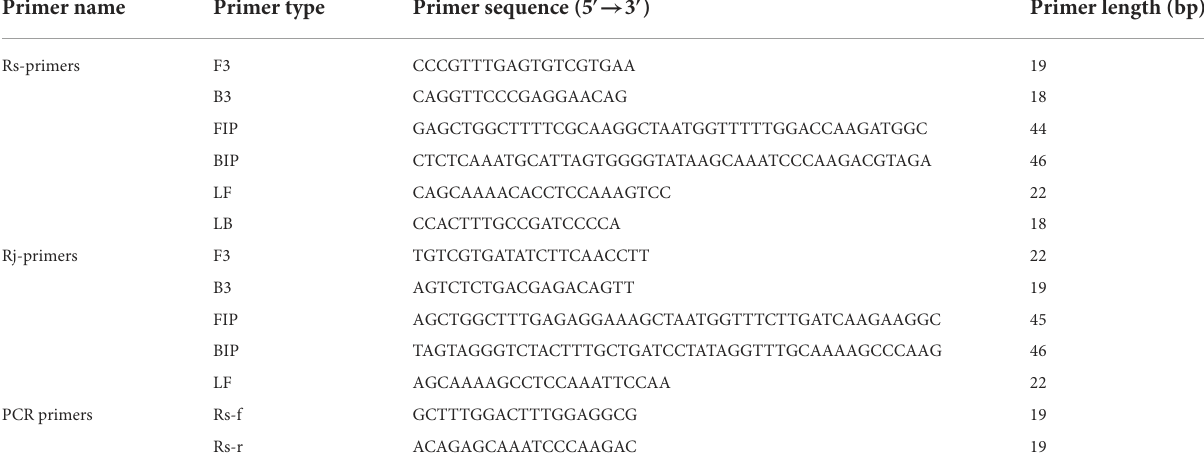
TABLE 2 Information on the species-specific primers used for loop-mediated isothermal amplification (LAMP).